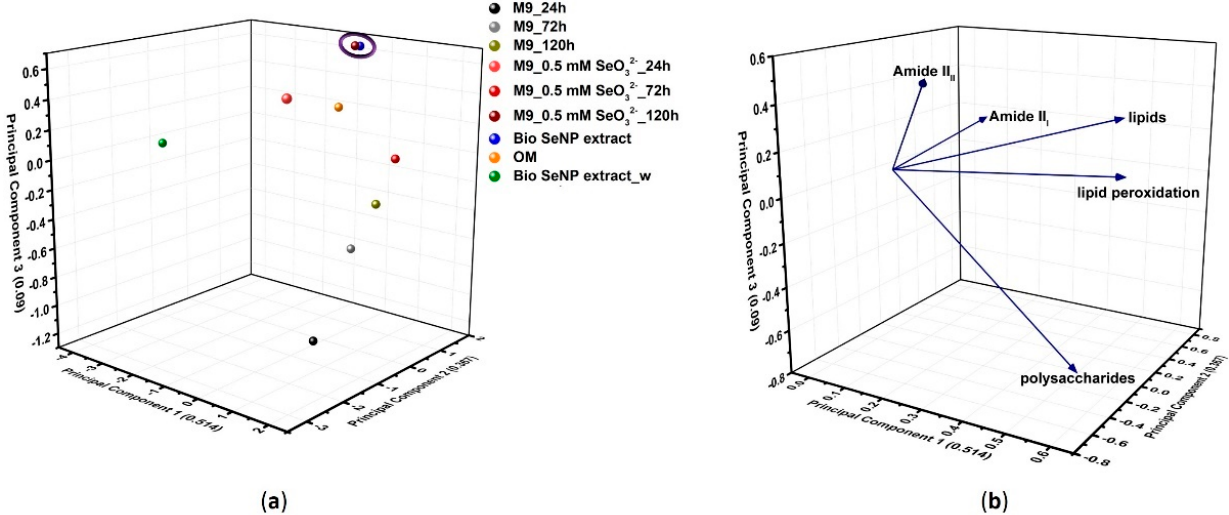
Figure 5. Representation of ( a ) score and ( b ) loading plots obtained through PCA performed on IR absorption bands contributing the most to samples’ variability (i.e., amide II, lipids, lipid peroxidation, and polysaccharides).